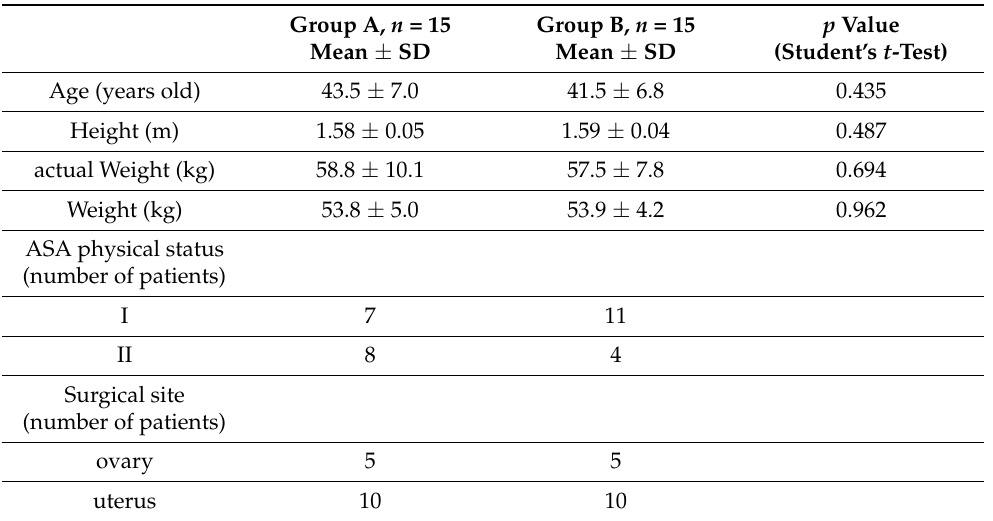
Table 1. Patient characteristics.